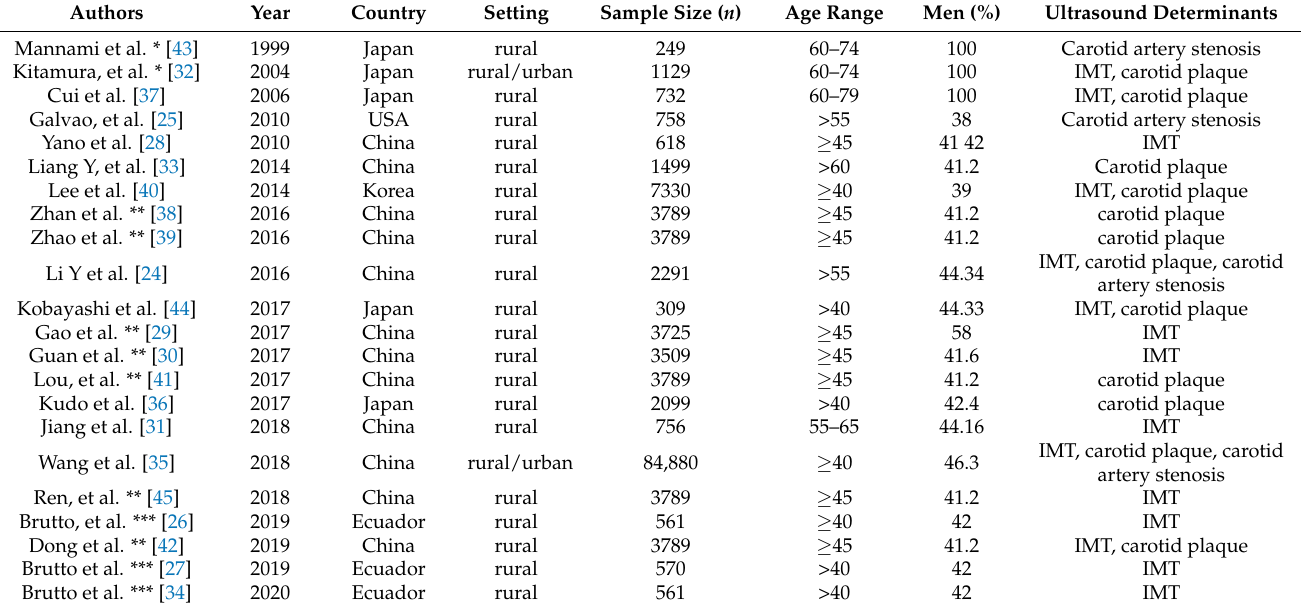
Table 1. Detailed characteristics of included studies (n = 22).